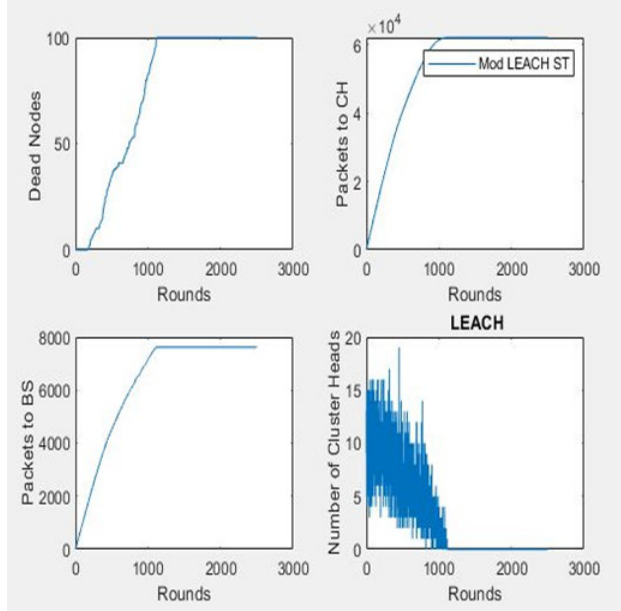
Figure 6. MOD – LEACH protocol Relation with dead nodes with rounds is given in figure 7 and 8. In 4 to 5 cluster nodes and until rounds of 2000 nodes of inter-cluster looks constant. Around 3000 and 4000 rounds, nodes of intra-cluster seems stabilized. In 8000 rounds, data packets which are thrown to sink (i.e.) WBAN transferred data packets 70bits transformation